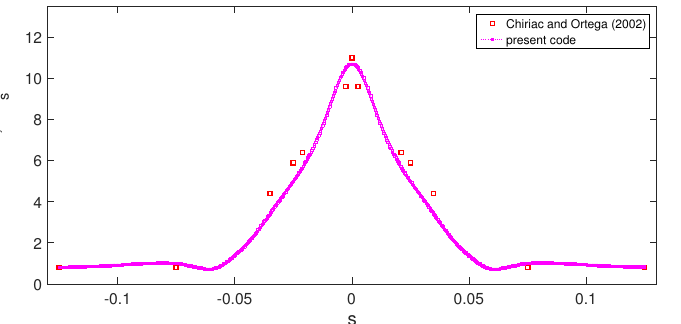
Figure 3. Code validation 1: average Nusselt number comparison with the results of [43] for different Hartmann numbers.